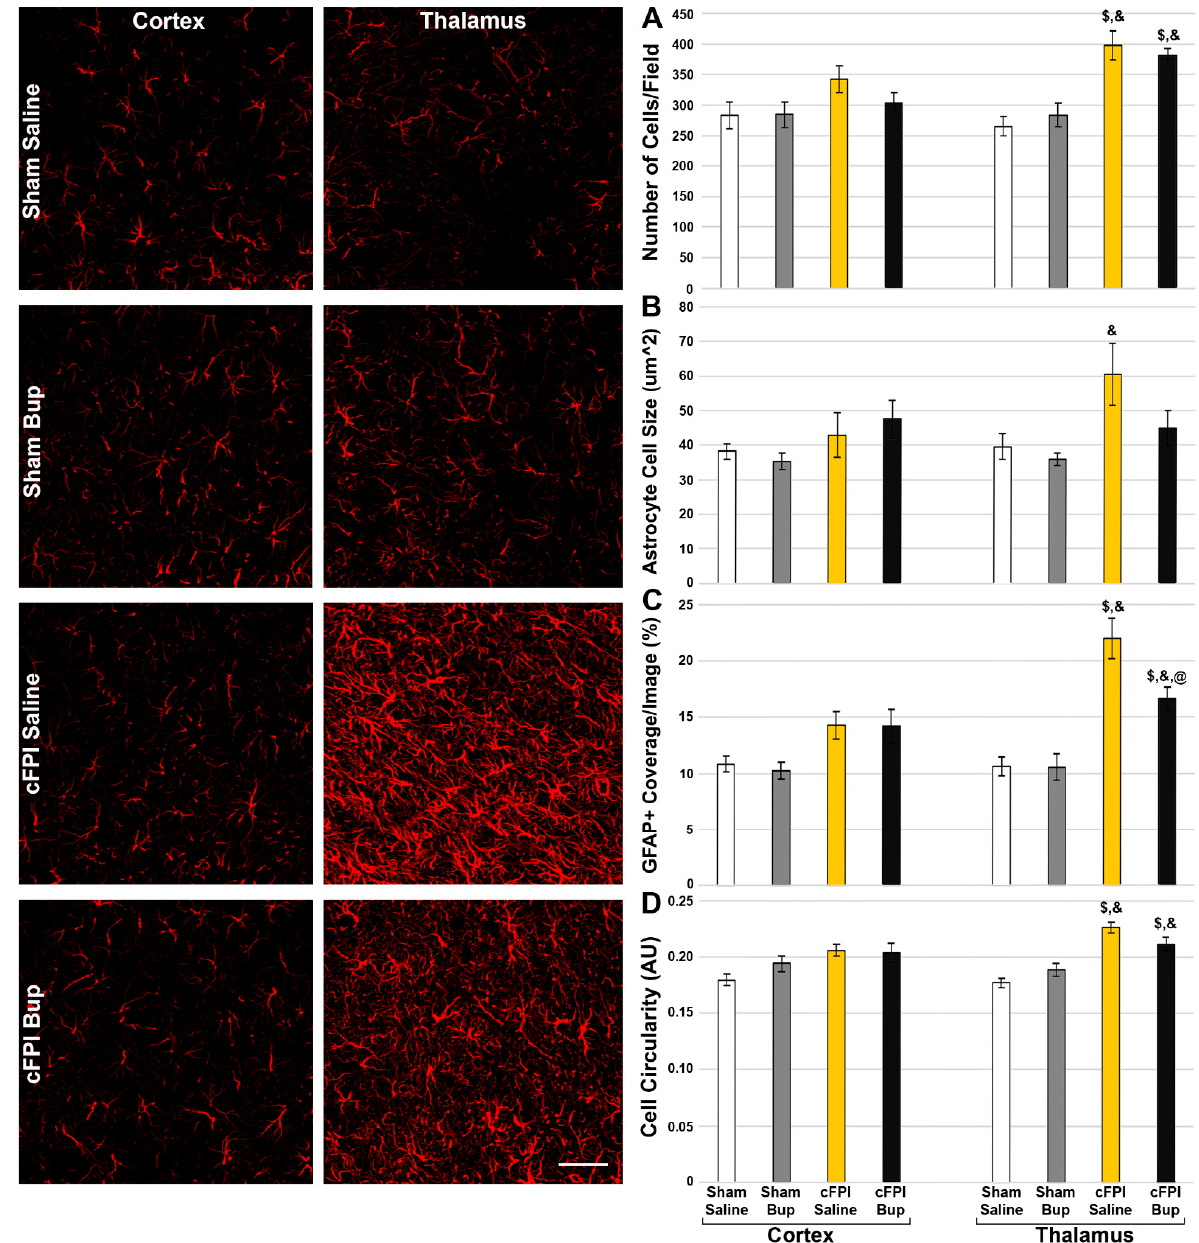
Figure 5. Treatment with Bup-SR-Lab (Bup) resulted in reduced astrocyte coverage in the thalamus. Representative photomicrographs of the astrocytic glial fibrillary acidic protein (GFAP) in the cortex and thalamus from rats 4w post-cFPI or sham and treated with saline or Bup. Bar graphs depicting astrocyte ( A ) cell number, ( B ) Average astrocyte cell size, ( C ) % of GFAP+ coverage/image, and ( D ) astrocyte cell circularity. While cortical astrocytes were not significantly changed following cFPI with or without Bup treatment, astrocytes within the thalamus demonstrated reduced circularity following cFPI and Bup. n = 6 rats/group. Mean ± SEM. Scale = 50 μ m. $ p < 0.05 compared to sham saline thalamus, & p < 0.05 compared to sham Bup thalamus, @ p < 0.05 compared to cFPI saline thalamus.